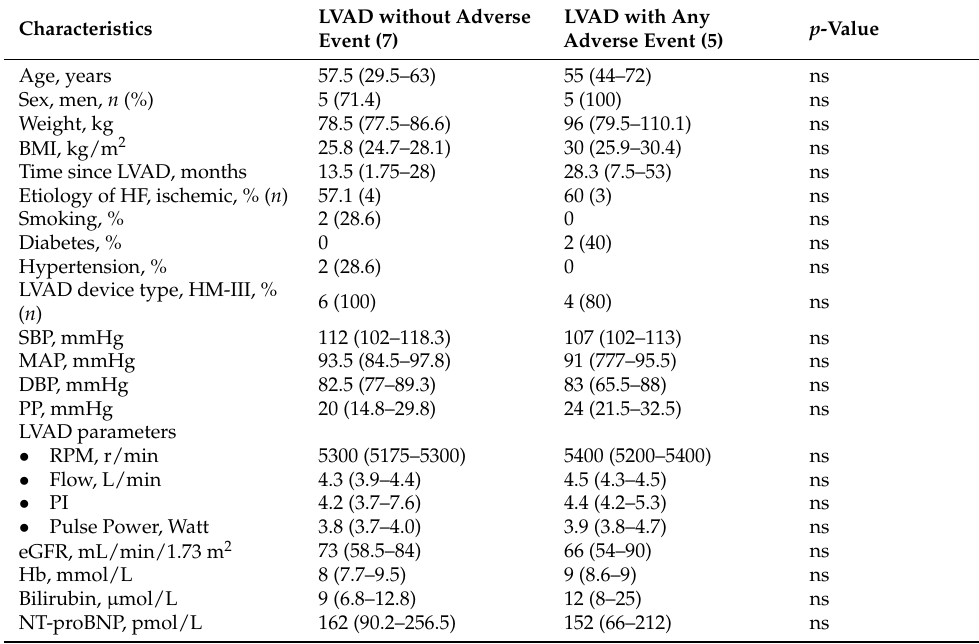
Table 3. Baseline characteristics of patients with an LVAD with and without any adverse event.